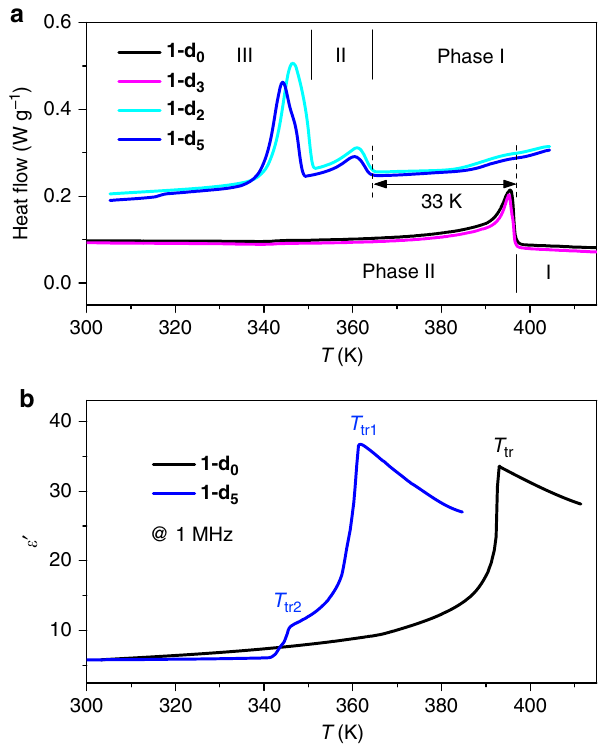
Fig. 2 Phase and dielectric transitions. a Differential scanning calorimetry curves of 1 upon cooling, showing two phases for the H isomorphs ( 1-d 0 and 1-d 3 ) and three phases for the D isomorphs ( 1-d 2 and 1-d 5 ). b The real parts of the dielectric constants ε ′ of 1-d 0 and 1-d 5 measured on crystal plates upon cooling, showing dielectric switching between low-dielectric and high-dielectric states. The largest dielectric responses appear on the [010] crystal plane, which is a cleavage plane and designated according to the crystal structures at 413 K in phase